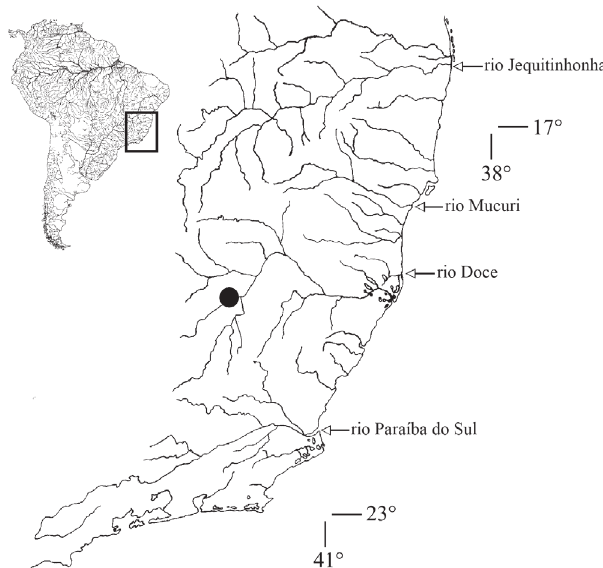
Fig. 4. Map of eastern Brazil showing type-locality of Pareiorhaphis scutula . One symbol represents more than one lot and